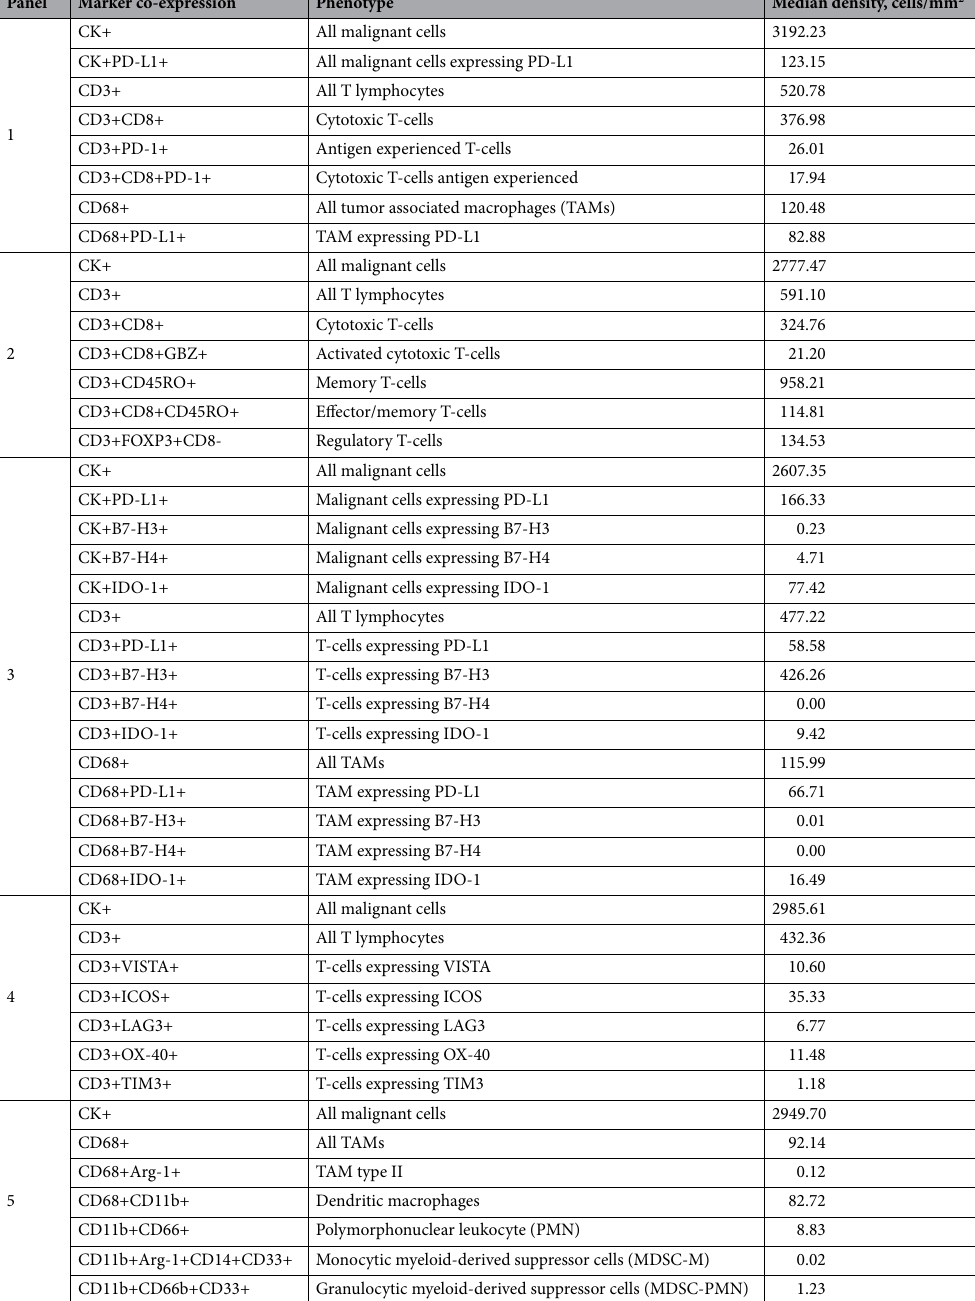
Table 1. The frequently observed phenotypes in the five multiplex immunofluorescence panels in the non- small cell lung cancer cohort (N =